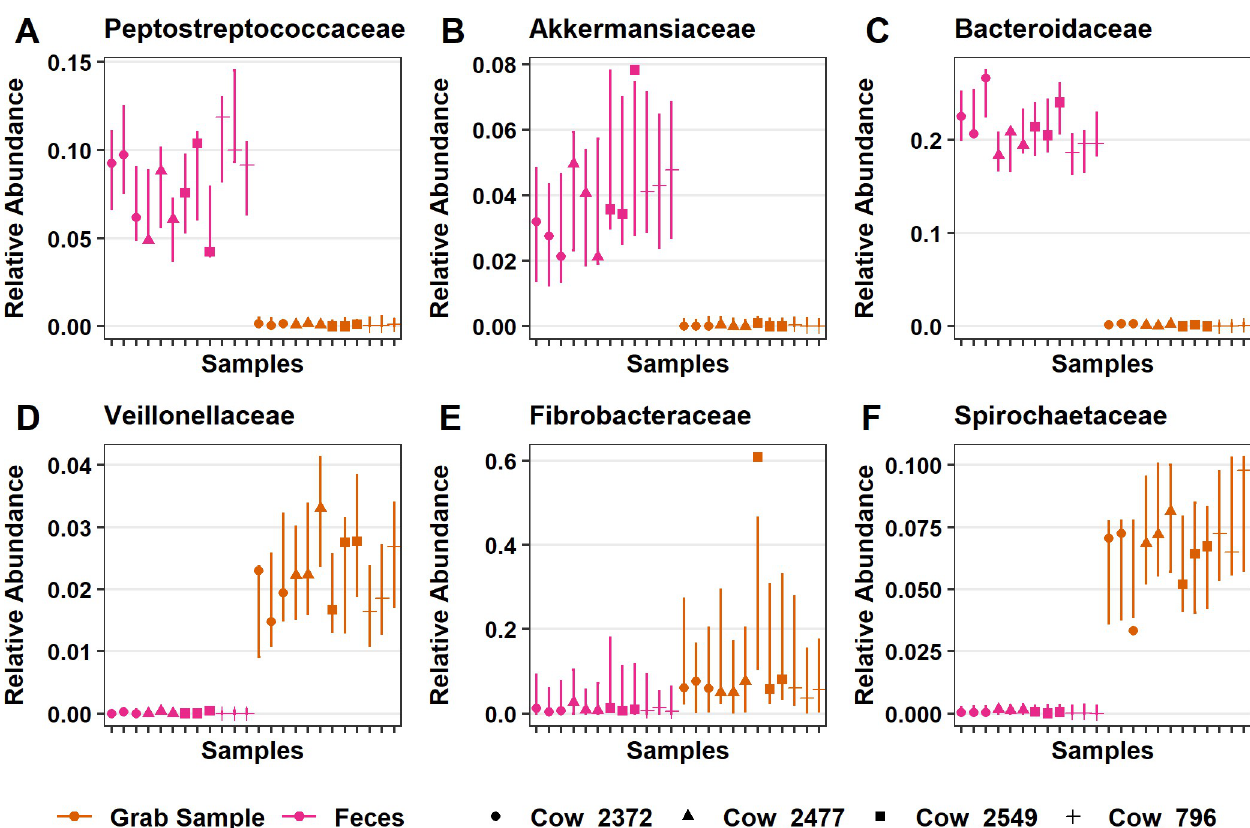
Fig 7. Significant differences in the relative abundance of specific bacterial families between fecal and grab samples. Fecal samples had significantly higher relative abundance of (A) Peptostreptococcaceae , (B) Akkermansiaceae , (C) Bacteroidaceae , compared to grab samples. Also, there was significantly lower relative abundance of (D) Veillonellaceae , (E) Bacteroidales_BS11_gut_group and (F) Spirochaetaceae compared to grab samples. Points are the estimated relative abundance and bars are a 95% prediction interval for each cow on different days of